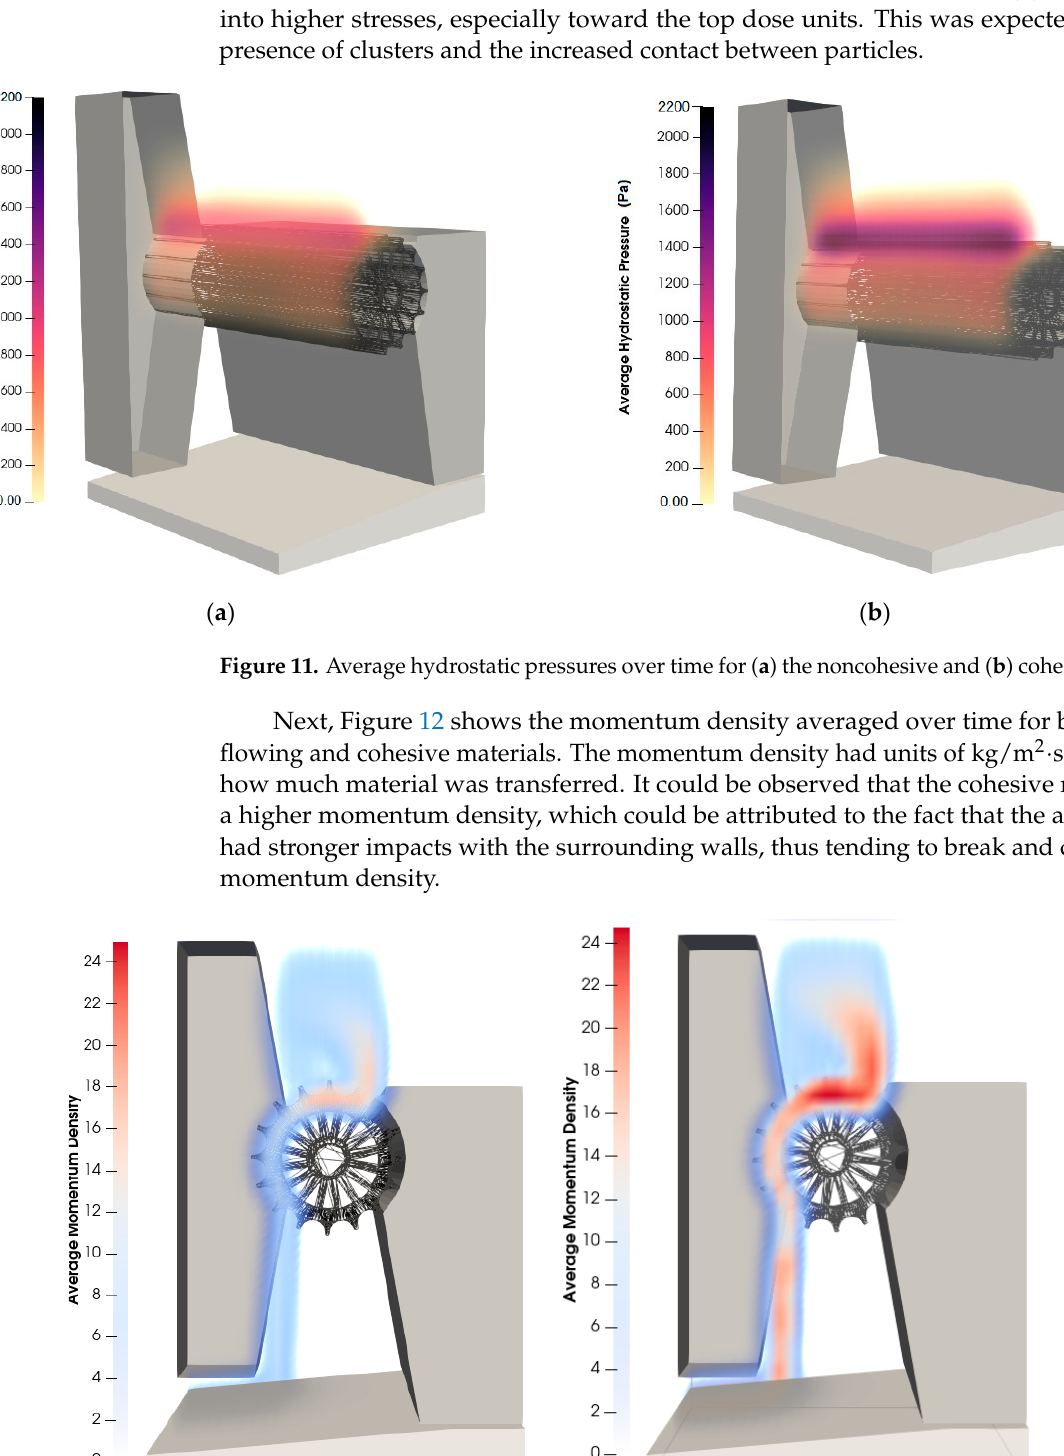
Figure 10. Average velocities over time for ( a ) the noncohesive and ( b ) cohesive materials.